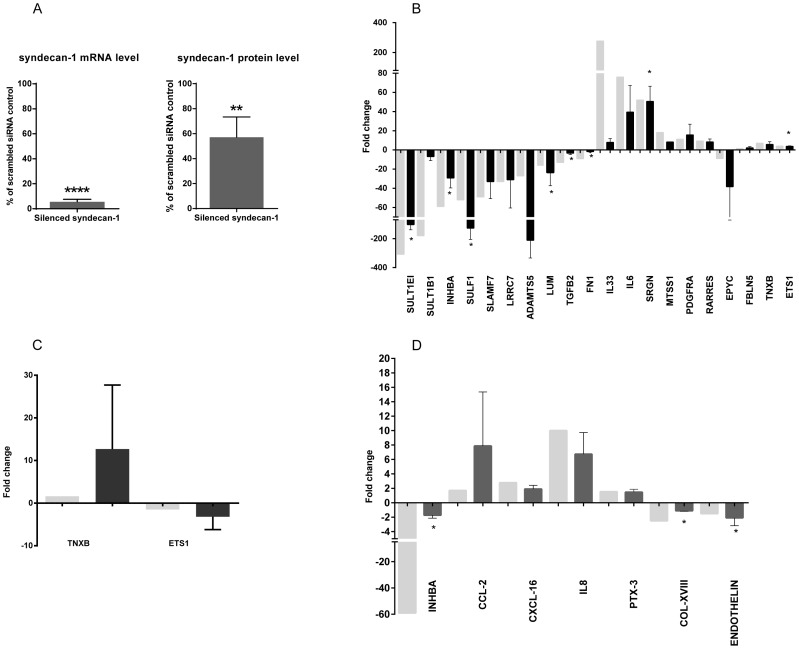
Validation of syndecan-1 silencing (A) and microarray data (B–D).(A) Succesful silencing of syndecan-1 was confirmed by RT-PCR and flow cytometry. The level of syndecan-1 mRNA (left column) and protein (right column) after silencing compared to cells treated with negative/scrambled control, 24 hours after silencing. The silencing is highly significant (p<0.0001 for mRNA and p<0.01 for protein ) as calculated by a one-sided t-test (n = 3). Selected transcripts deregulated in microarray were analyzed by RT-PCR for syndecan-1 overexpression (B) and silencing (C) and/or by proteome profile array (D) for syndecan-1 overexpression. mRNA or protein level of cells with modulated syndecan-1 was compared to their specific control (vector for overexpressed and negative-scrambled for silenced). Results are given in fold changes (FC). Light gray columns represent the values obtained by microarray, dark gray columns correspond to the results from RT-PCR or from proteome profiler array. Each value represents an average of fold-changes of three independent experiments, error bars represent standard deviation (SD); statistically significant changes: *p<0.05, ** p<0.01, **** p<0.0001 for differential expression of transcripts in syndecan-1 modulated cells compared to the corresponding controls.